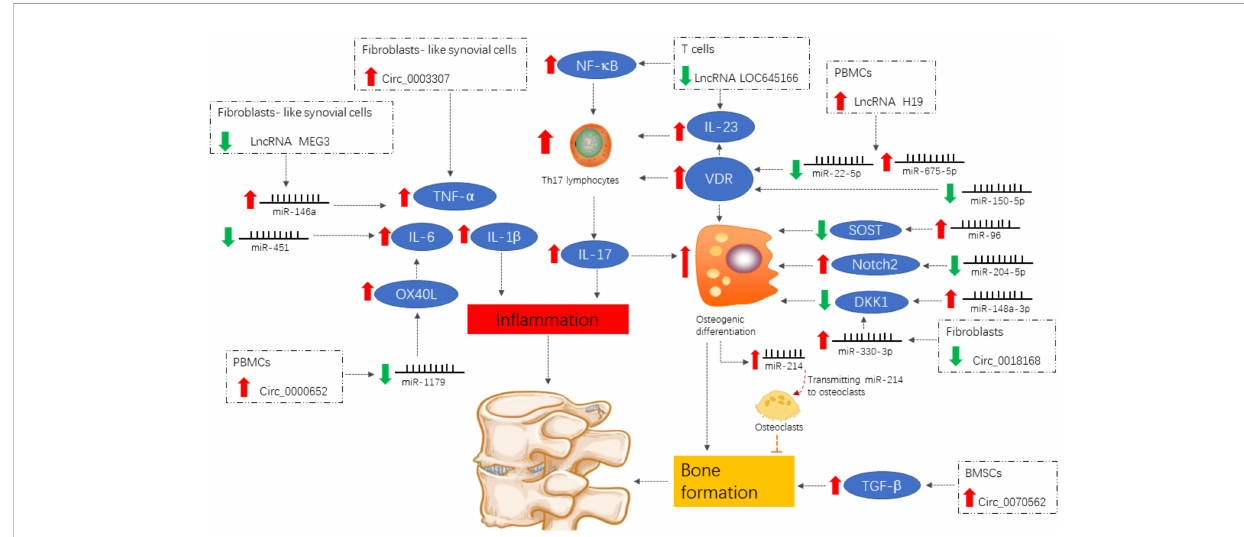
FIGURE 2 Differentially expressed ncRNAs of functional importance in ankylosing spondylitis. Signals are focused on the induction of the pro-in fl ammatory cytokines IL-1 b , TNF- a , and IL-6 and the enhancement of the IL-23/IL-17 axis, both of which contribute to in fl ammation and abnormal bone